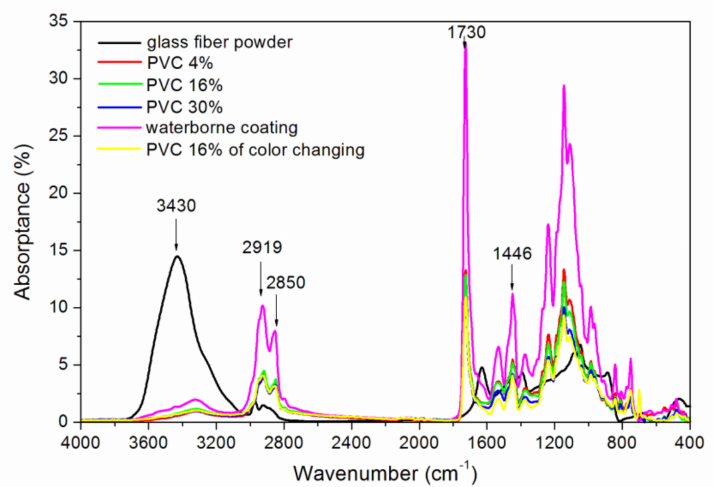
Figure 6. FT-IR of the thermochromic waterborne coating with di ff erent PVC of glass fiber